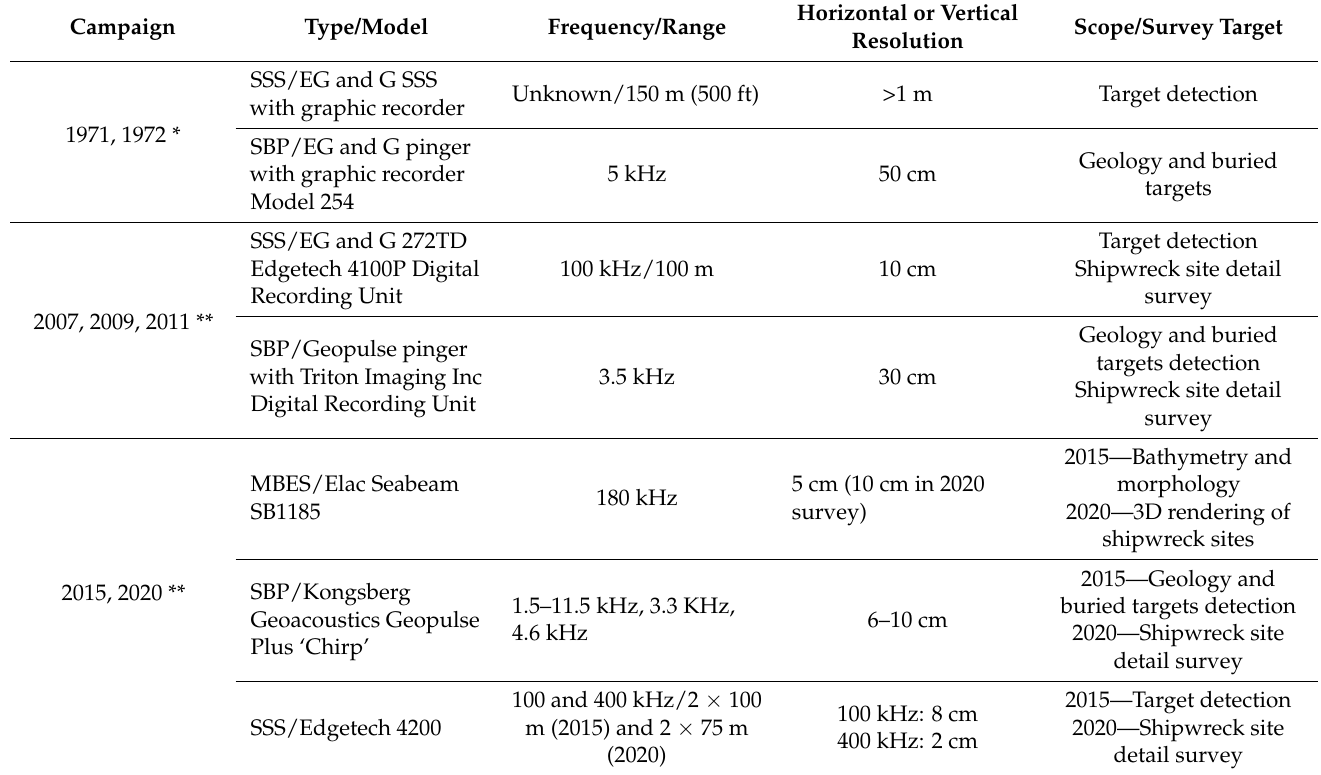
Table 1. Sensor device characteristics against survey target analyses for the original survey [15] and each campaign of the present